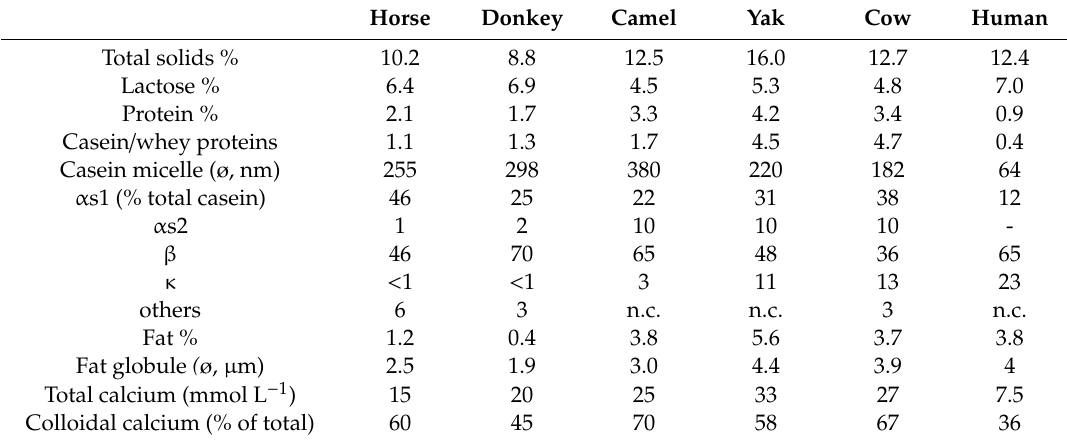
Table 1. Compositional aspects of technological relevance of minor milks (average values from the cited literature); n.c. = not considered. Horse Donkey Camel Yak